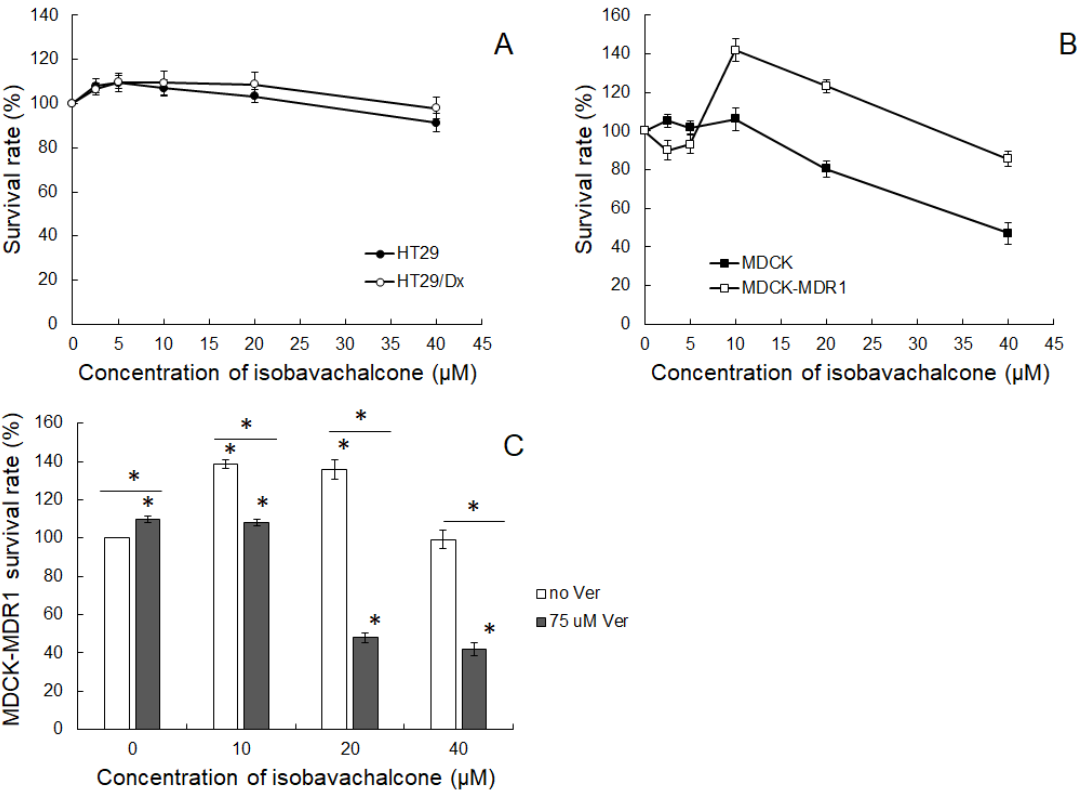
Figure 1. SRB cytotoxicity assay of IBC in HT29 and HT29/Dx ( A ), and MDCK and MDCK-MDR1 cells ( B ), and of IBC in combination with 75 µ M Ver in MDCK-MDR1 cells ( C ). The means of three experiments ± SD are presented (* p < 0.05). Statistical significance was checked between the studied probes and controls (no IBC) and between probes containing only IBC and IBC combined with Ver. Statistical significance was achieved: in panel A for HT29 cells for 2.5, 5, and 40 µ M IBC, in HT29/Dx for 2.5 and 5 µ M IBC; in panel B for MDCK cells for 20 and 40 µ M IBC, and in MDCK-MDR1 cells for 10, 20, and 40 μ M IBC.